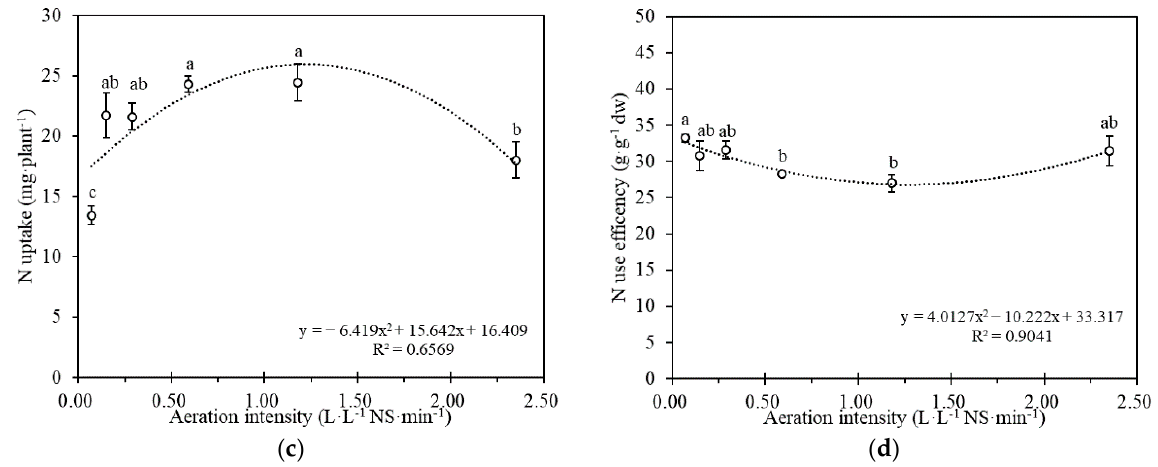
Figure 7. Plant nutrient uptake and nitrogen use efficiency under different aeration intensities. ( a ) N content (shoots), ( b ) N content (roots), ( c ) N uptake, and ( d ) N use efficiency. Bars labeled with different letters indicate significant differences ( p ≤ 0.05); data are expressed as MSE ( n = 4).